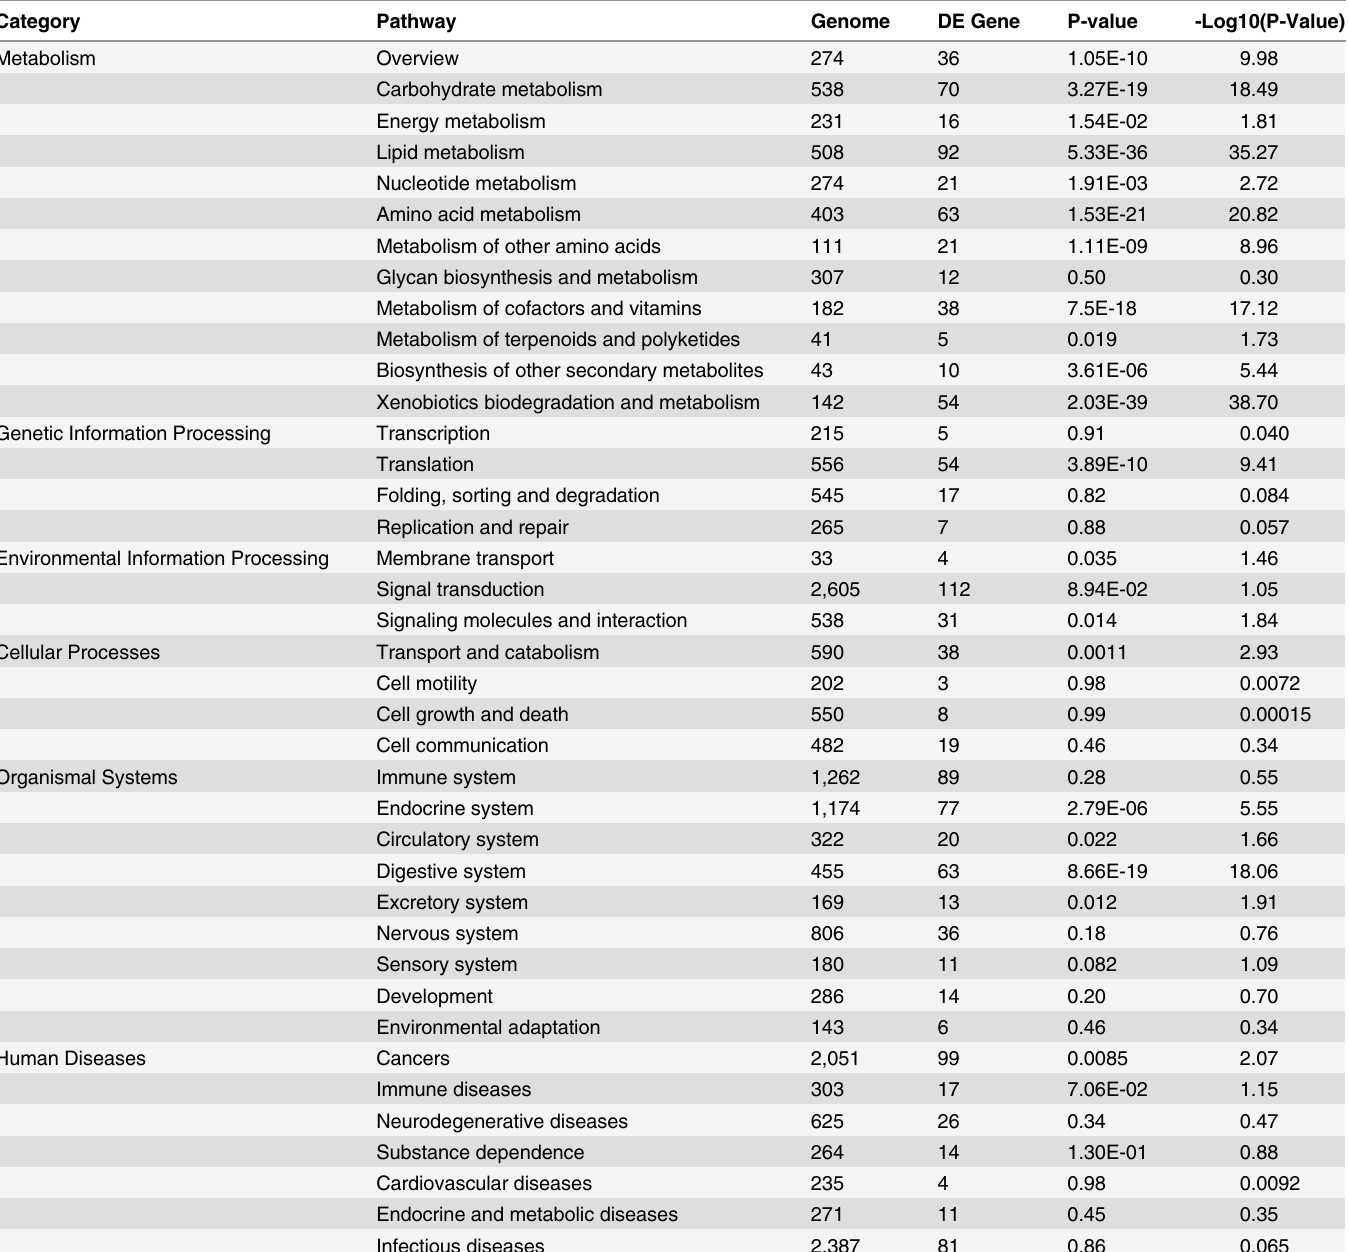
Table 5. DE genes pathways classification of C . idella